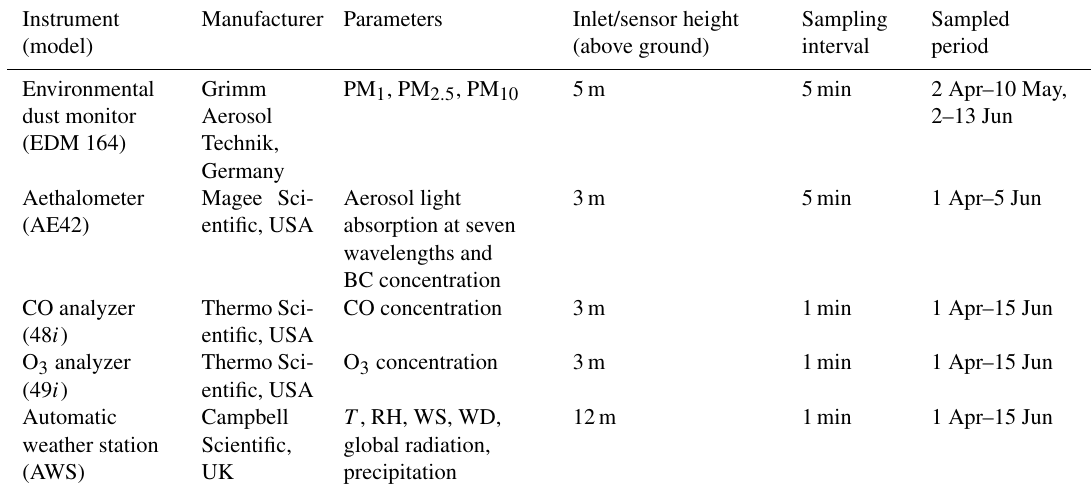
Table 1. Summary of instruments deployed during monitoring in